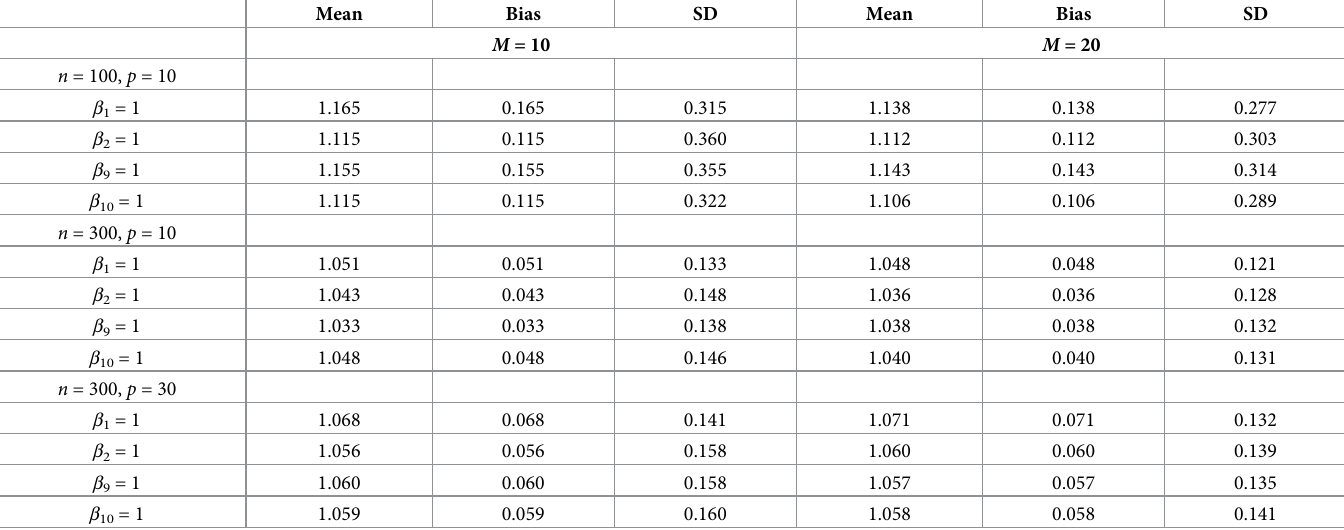
Table 4. Simulation result of appIC sparse estimation with b 0 = 1 and baseline cumulative hazards function Λ 0 ( t ) = log ( t + 1).